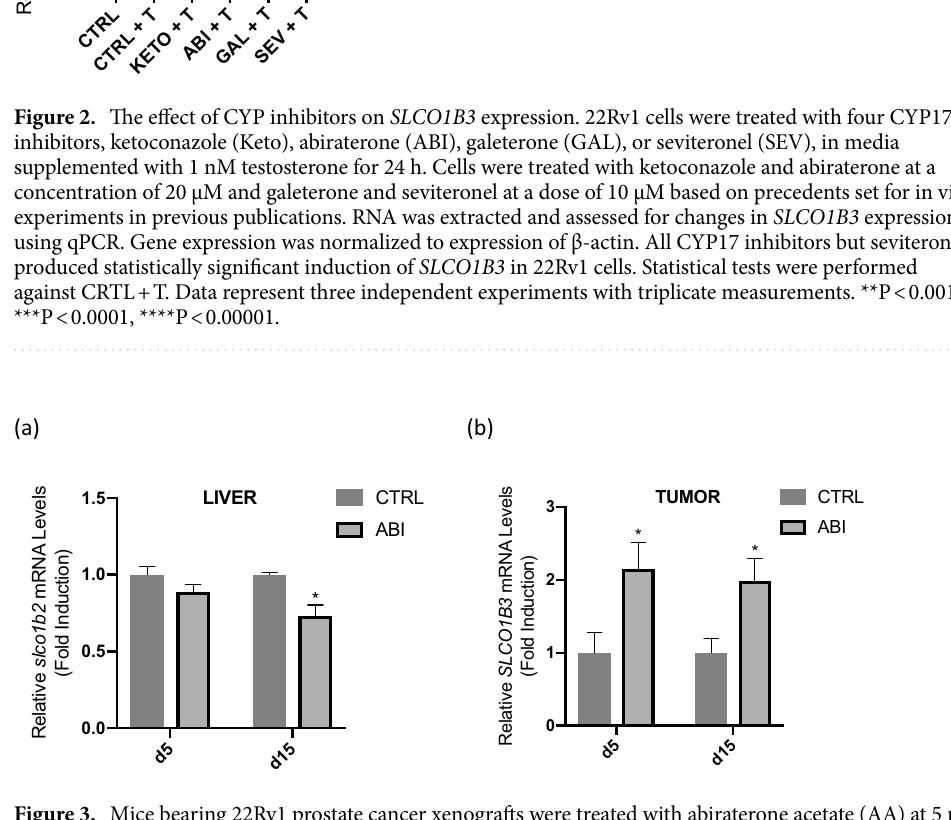
Figure 3. Mice bearing 22Rv1 prostate cancer xenografts were treated with abiraterone acetate (AA) at 5 mmol/ kg/day or vehicle control (95% safflower oil, 5% benzyl alcohol) via intraperitoneal injection every day for either ( a ) 5 or ( b ) 15 days. RNA was extracted from harvested tumor or liver tissue and reverse transcribed for analysis by qPCR. Gene expression was normalized to expression of β-actin. Significant upregulation of SLCO1B3 was observed at both time points. Mouse livers were assessed for changes in slco1b2 (the mouse analogue of human SLCO1B3 ) expression. While AA treatment induced a statistically significant decrease in mouse liver slco1b2 expression, the magnitude of the change was small and may not reflect how SLCO1B3 expression in a human liver would be affected by AA treatment. *P <